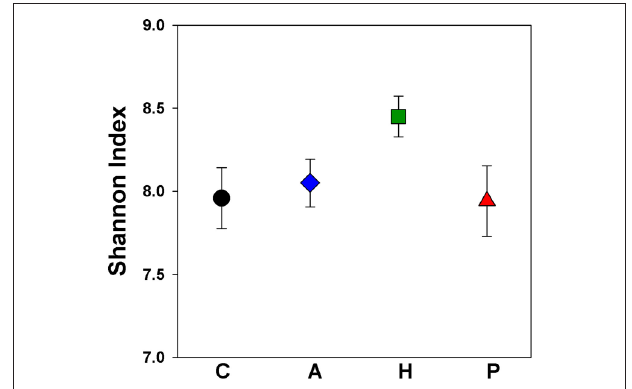
FIGURE 2 | Shannon index of microbial communities in the ceca of voles selected for different traits. Points represent mean ± SEM . C, Control; A, Aerobic; H, Herbivorous; P, Predatory. Herbivorous-selected lines exhibited significantly higher biodiversity.